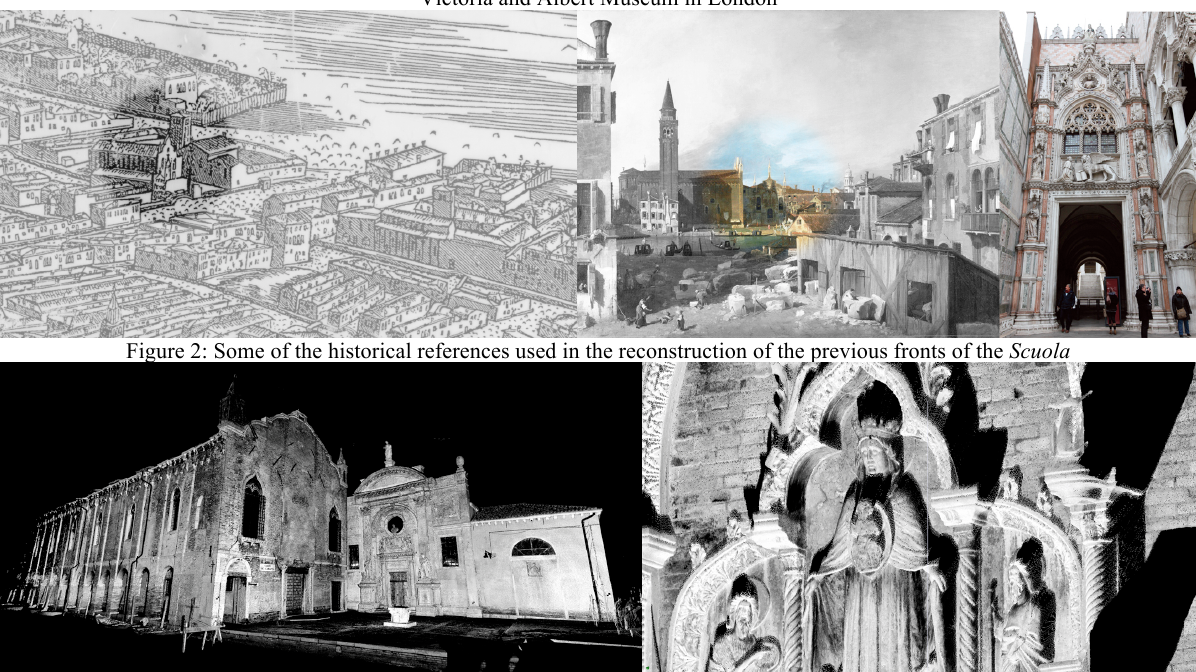
Figure 3: The point clouds of the façade and a detail of the removed portal in